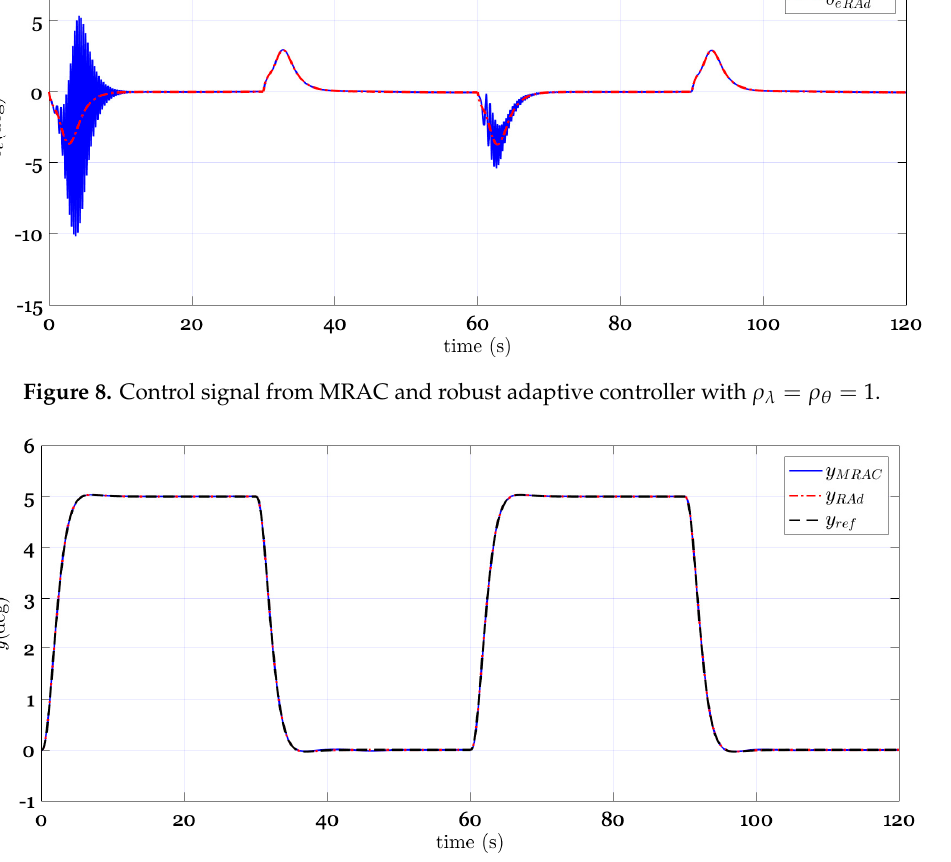
Figure 9. Tracking performance for MRAC and robust adaptive controller with ρ λ = ρ θ = 10.